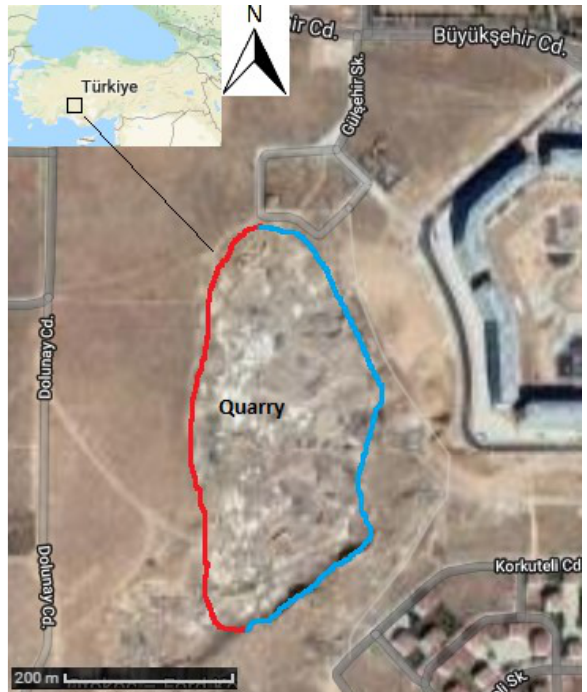
Figure 1. Geographical position of the study area (Latitude: 37o.58’13”.18 N, Longitude: 37o. 30’07” E). Red line shows measured cliff on border of the quarry. (Image is from Google Maps)